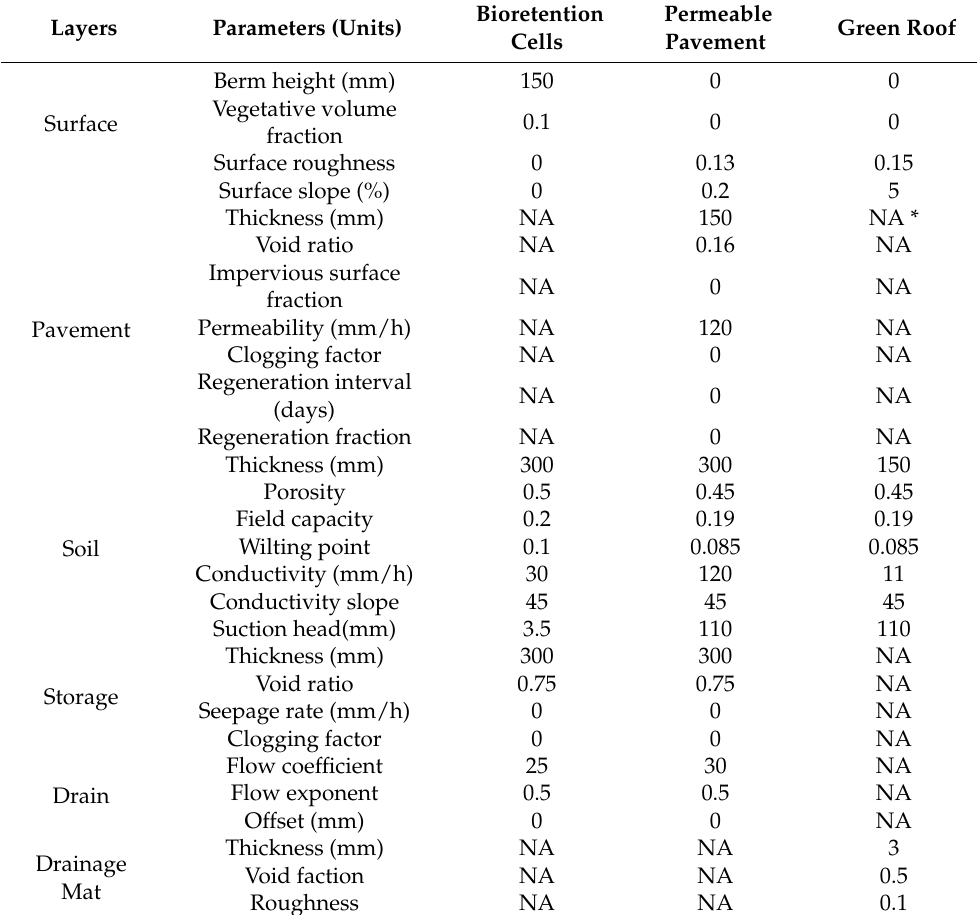
Table 5. Parameters of LID controls used in the